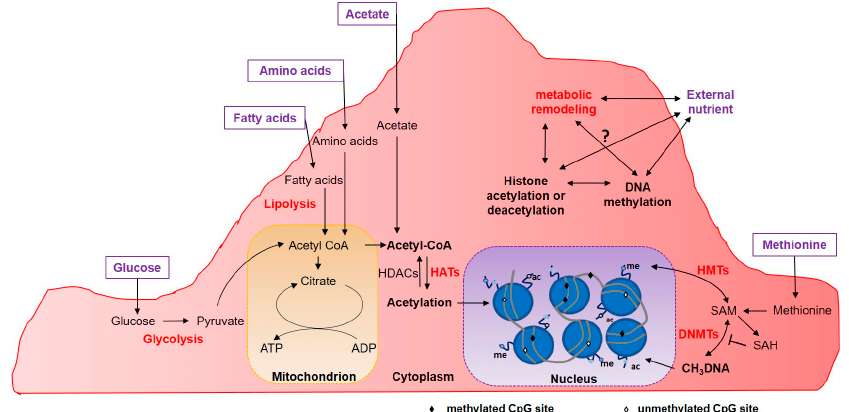
Figure 2. Metabolic reprogramming of EC derived from the intrinsic and extrinsic microenvironment. Acetyl-CoA derived from glucose, fatty acid, amino acid or acetate metabolism is the substrate for histone acetylation driven by HATs. Metabolic remodeling can upregulate enzymatic activity from